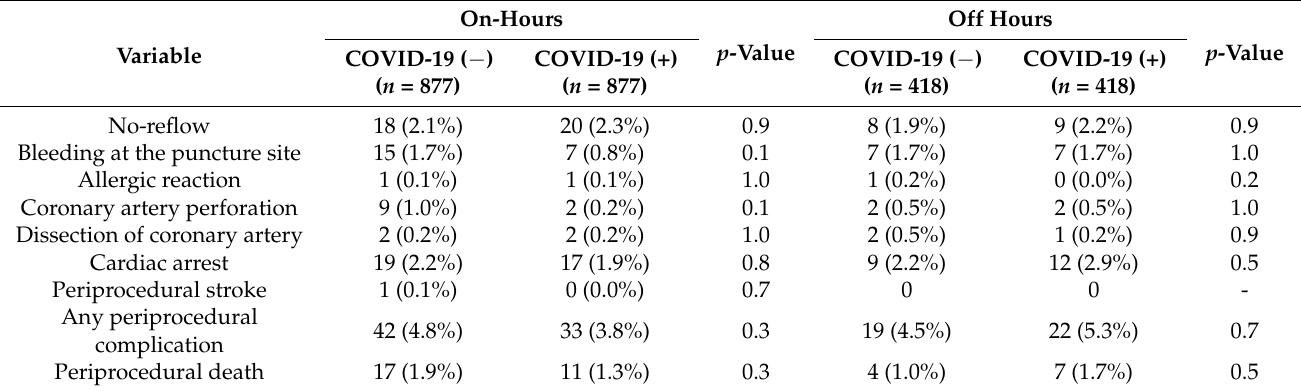
Table 4. Periprocedural outcome after propensity score matching.